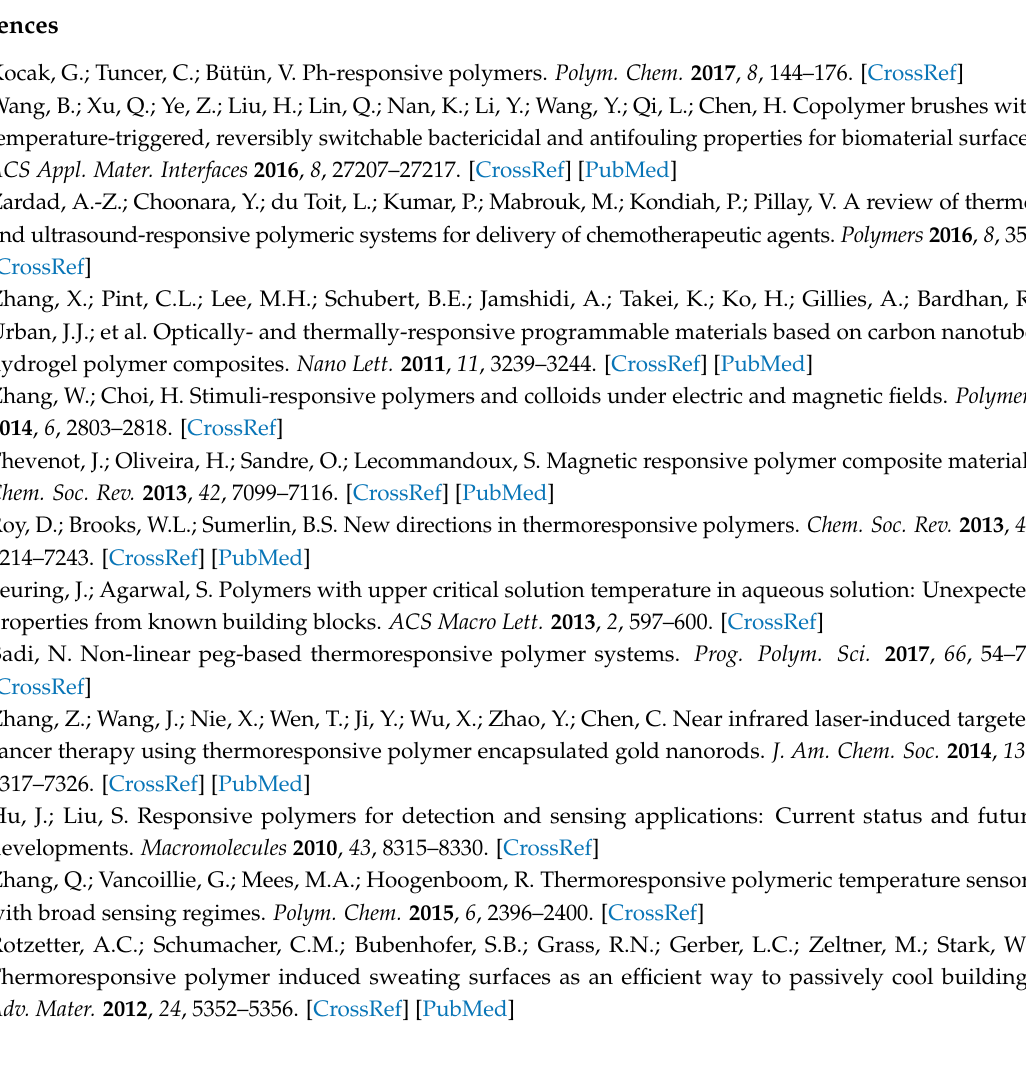
Figure S1: Illustration for the structure of amylopectin and grafted copolymer, Scheme S1: Synthesis of waxy potato starch-based ATRP macroinitiator and St-g-PAM, Figure S2: FTIR spectra of Starch-Br with different DS, Figure S3: 1 H-NMR (a), 13 C-NMR (b) and gHSQC (c) spectra of St-Br (DS = 0.13) in D 2 O, Figure S4: Molecular weight distribution of St-Br, St-g-PNIPAM-P0 before and after hydrolysis (St-g-PNIPAM-P0-H), Figure S5: Viscosity versus temperature of PAM (M n = 35200) with 1.5 wt % copolymer concentration ( γ = 1 s − 1